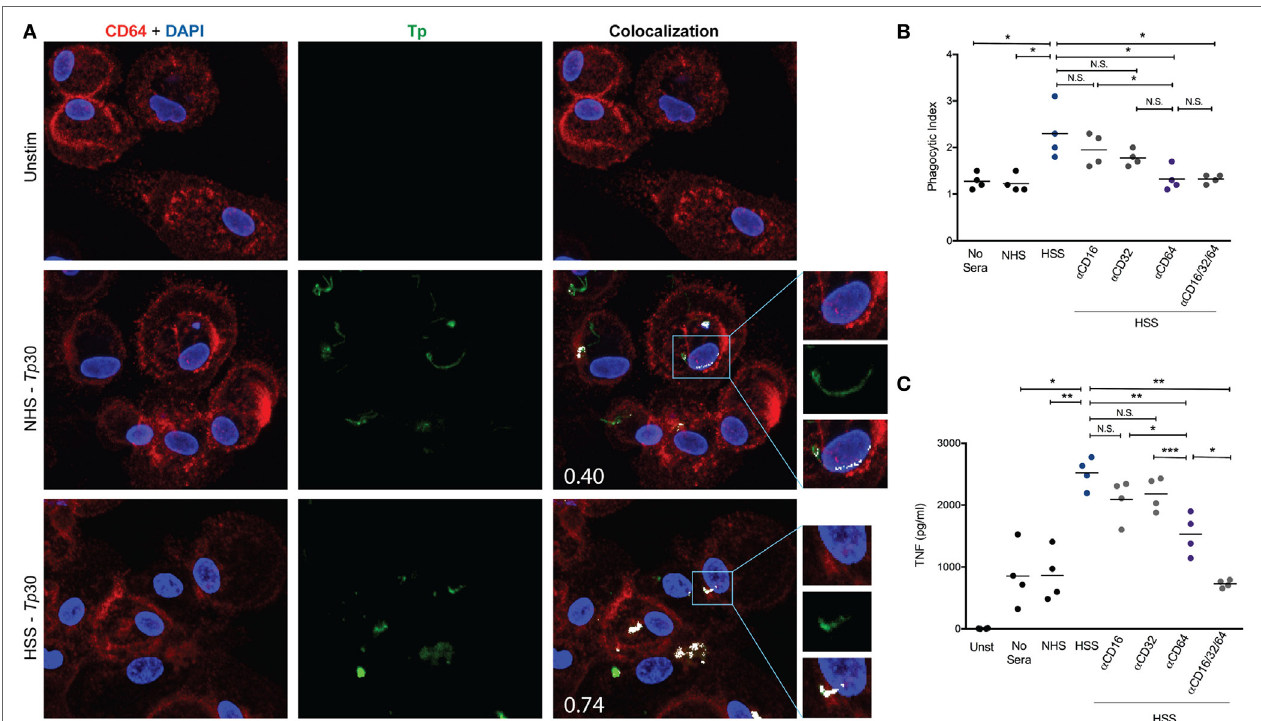
FigUre 7 | CD64 is the primary phagocytic receptor. Mouse anti-human CD64 and polyclonal rabbit anti- Tp antibodies were used to identify locations of Fc γ receptors (Fc γ Rs) and spirochetes on the cell surface by confocal microscopy. (a) Colocalization of CD64 (red pixels) and Tp (green pixels) were determined by ImageJ plug-in “JACoP” and are represented by white pixels. Mander’s colocalization coefficient values (M2), shown in the lower left corner of colocalization images in A, are indicative of the proportion of the green signal overlapping with the red signal. (B,c) The blockade of Fc γ Rs on the surface of M Φ (IFN γ )s was achieved by pre-incubating macrophages with 10 µg/ml of mouse anti-human CD16 (clone 3C8), mouse anti-human CD32 (clone 6C4), mouse anti-human CD64 (clone 10.1), or 10 µg/ml of each of the three antibodies for 1 h prior to Tp –macrophage stimulating at an multiplicity of infection (MOI) 30:1 with no sera, normal human serum (NHS), or human syphilitic serum (HSS) for an additional 8 h in an eight-well chamber slide. (B) Phagocytic index is shown and compared between each of the five conditions studied. (c) Cytokine bead array was used to detect inflammatory cytokine production following stimulation with Tp and shown in the dot plot for each of the five conditions studied. The statistical significance between the Tp conditions was determined by Friedman’s test with a Dunnett’s multiple comparison post-test analysis. N.S., not significant, * p -value of < 0.05, ** p -value of <